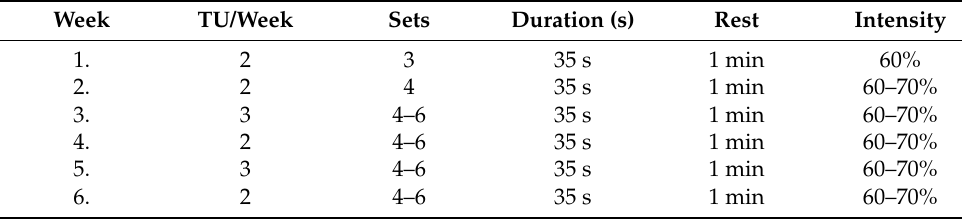
Table 1. Presentation of the training